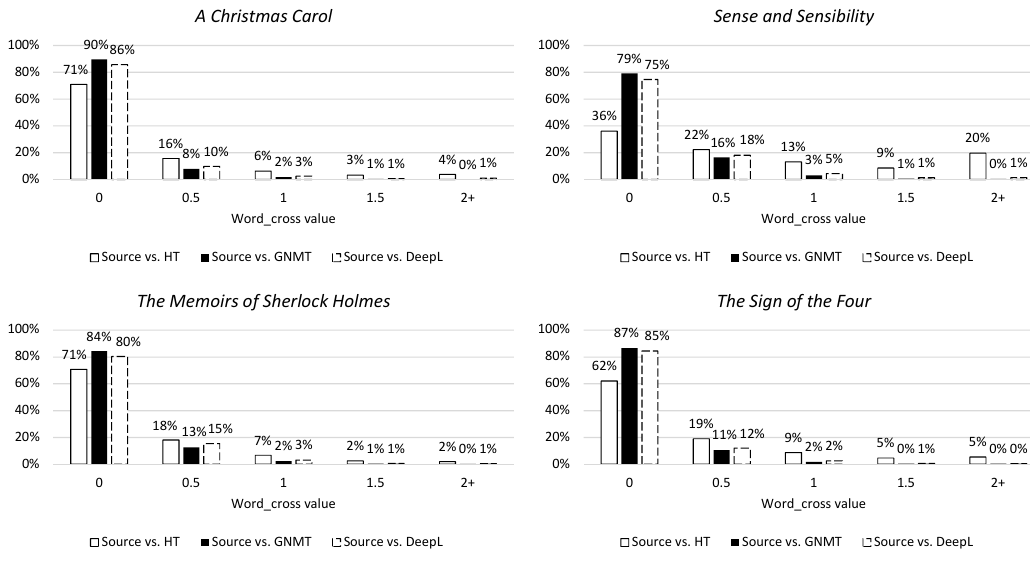
Figure 10. Distribution of word_cross values in percentages per novel. The 0 column contains values [0:0.5[ , the 0.5 column values [0.5:1[,